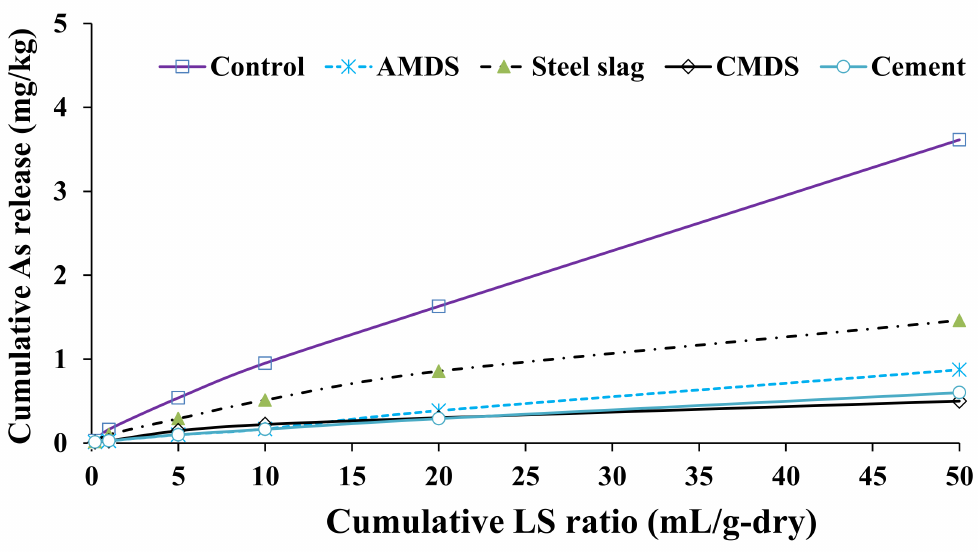
Figure 6. The cumulative release of arsenic from contaminated (control) and stabilized soils as a function of L/S ratio by the column percolation